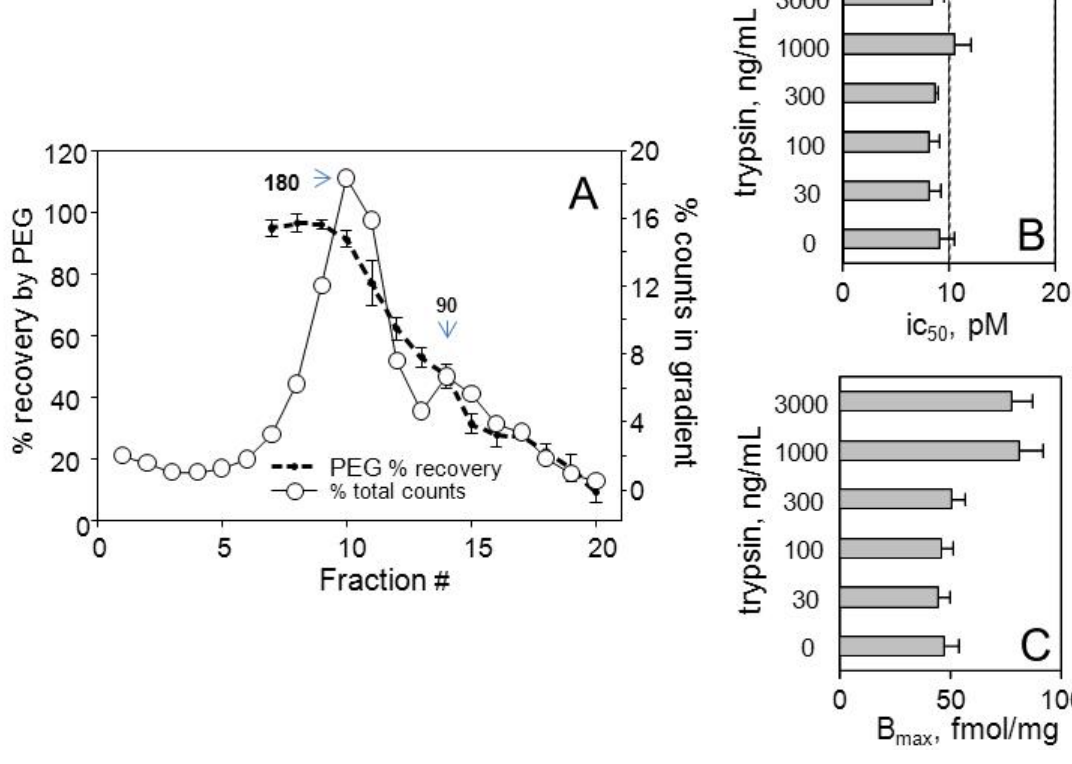
Figure 6. Stability and affinity of agonist binding differs greatly for heteropentamer and monomer forms of the rabbit kidney Y2 receptor. ( A ) Y2 agonist attached to 180 kDa heteropentamer is recovered completely by 10% polyethyleneglycol (PEG) at 0.3 M K + (The data are averages of six gradients, ±1 S.E.). The ic50 for PYY(3-36) binding for the entire receptor complement varies between 0.2 and 0.5 nM, depending on proportions of agonist bound to 180 and 90 kDa complex, and detached from the monomer-Gi α during sedimentation. Note that there is no free intact or partially degraded [ 125 I ]PYY(3-36) in particulates before lysis by digitonin and cholate, and degradation of the receptor-bound tracer is very low; ( B ) Y2 agonist bound to the 90 kDa monomer-Gi α is detached by 8 mM cholate at 0–5 °C (or by 0.3 M KCl) and the affinity of PYY(3-36) binding to the >90% dimeric residue is unaffected by trypsin at up to 3 µg/mL and has ic50 for PYY(3-36) close to 10 pM; ( C ) The B for the dimeric Y2 in the cholate residue increases significantly max above 0.3 µg trypsin, indicating a proteolytic disaggregation of the agonist-inaccessible